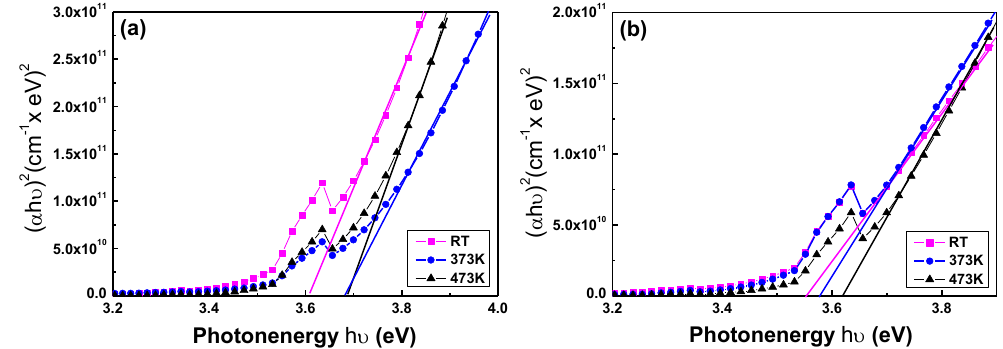
Figure 5. The (αhν) 2 vs. hν -Eg plots of the GZO thin films deposited as a function of deposition temperature and on different substrates: ( a ) glass and ( b ) PI. Table 2. Optical properties and the optical band gap ( Eg ) values of the GZO thin films deposited on different substrates and at different temperatures and ZnO thin films deposited on different substrates.